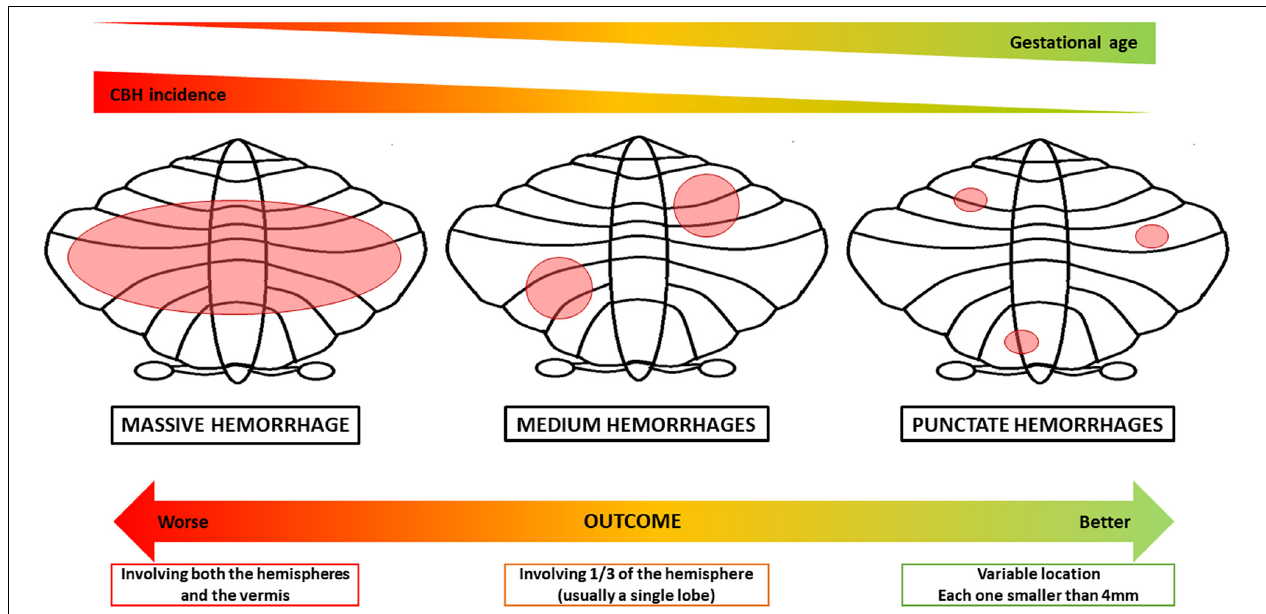
FIGURE 2 | Types of cerebellar hemorrhage in relation to possible timing and outcomes. The picture shows the possible correlation between lower gestational ages of birth and higher incidence of larger hemorrhages, concerning outcomes. Massive hemorrhage usually involves both the hemispheres and the vermis and can be related to supratentorial lesions, i.e., IVH. It has the worst outcome, leading to generalized cerebellar atrophy and to significant neurological sequelae, presenting the highest mortality rate. Medium hemorrhages involve only one-third of the cerebellar hemisphere, hence usually a single lobe (i.e., anterior or posterior lobe). It frequently evolves in focal atrophy and a variable neuropsychiatric outcome, typically milder than the massive one. Punctate hemorrhage is smaller than 4 mm. Generally, it does not lead to cerebellar hypoplasia and presents minimal neurological abnormalities, depending on the lesion site (Volpe, 2009; Zayek et al., 2012; Boswinkel et al., 2019; Gano and Barkovich,